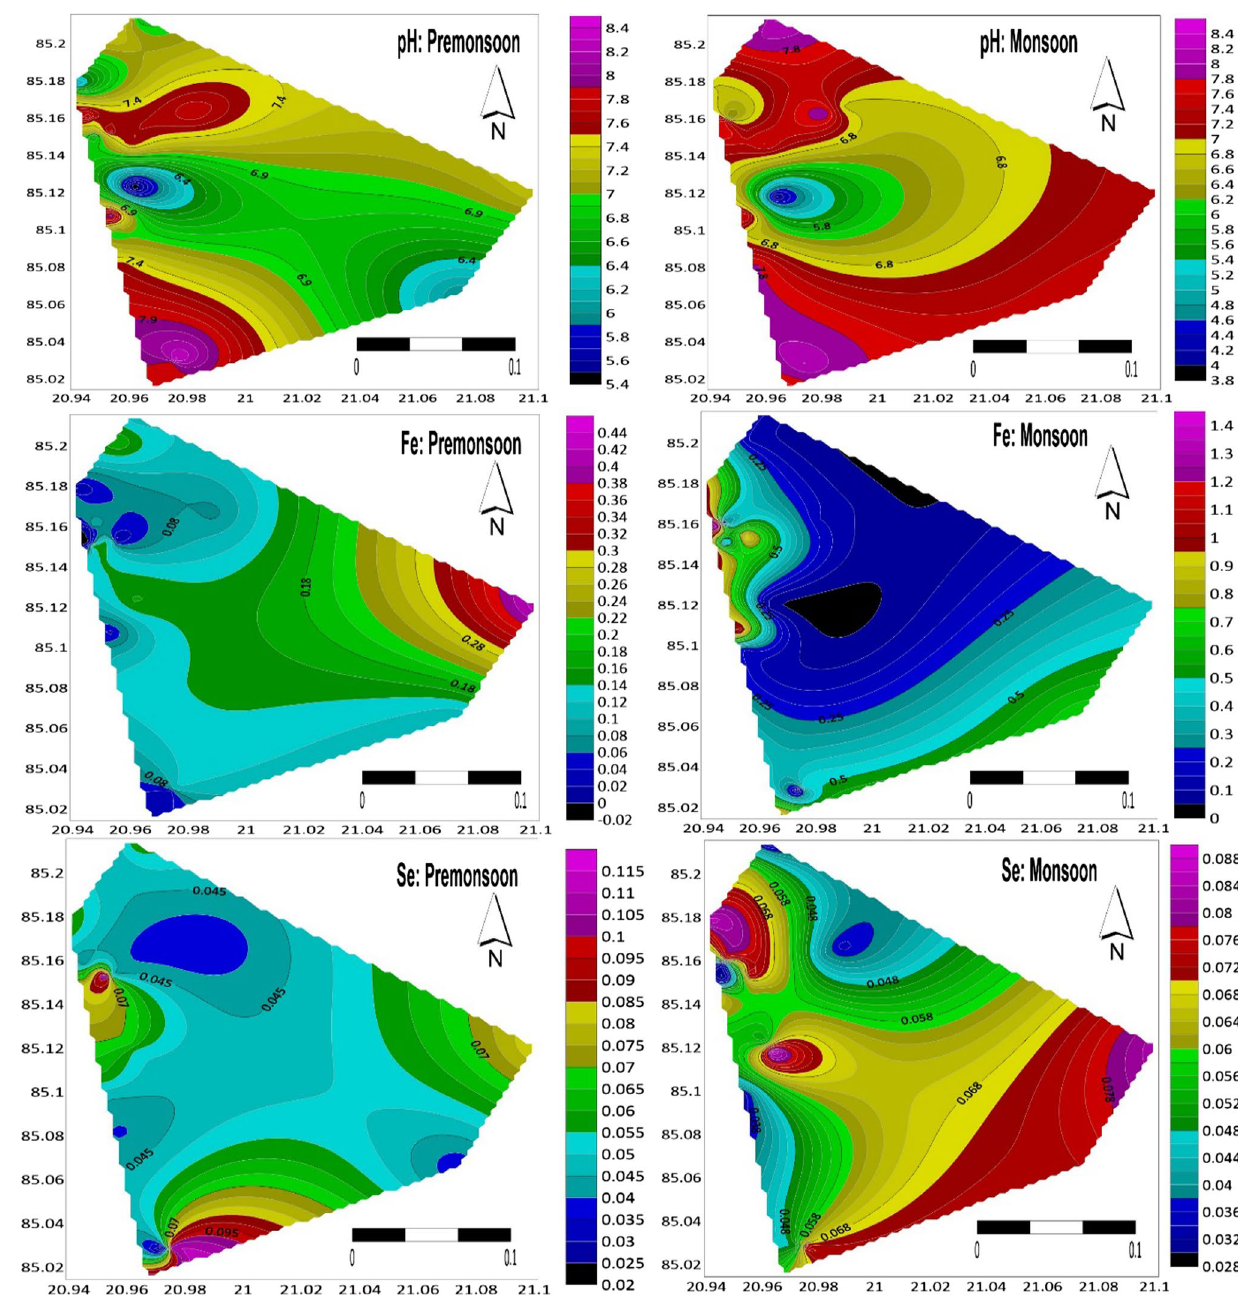
Fig. 3 Concentration contour map of pH, Fe, Se in the water samples of Talcher coalfield during pre-monsoon and monsoon